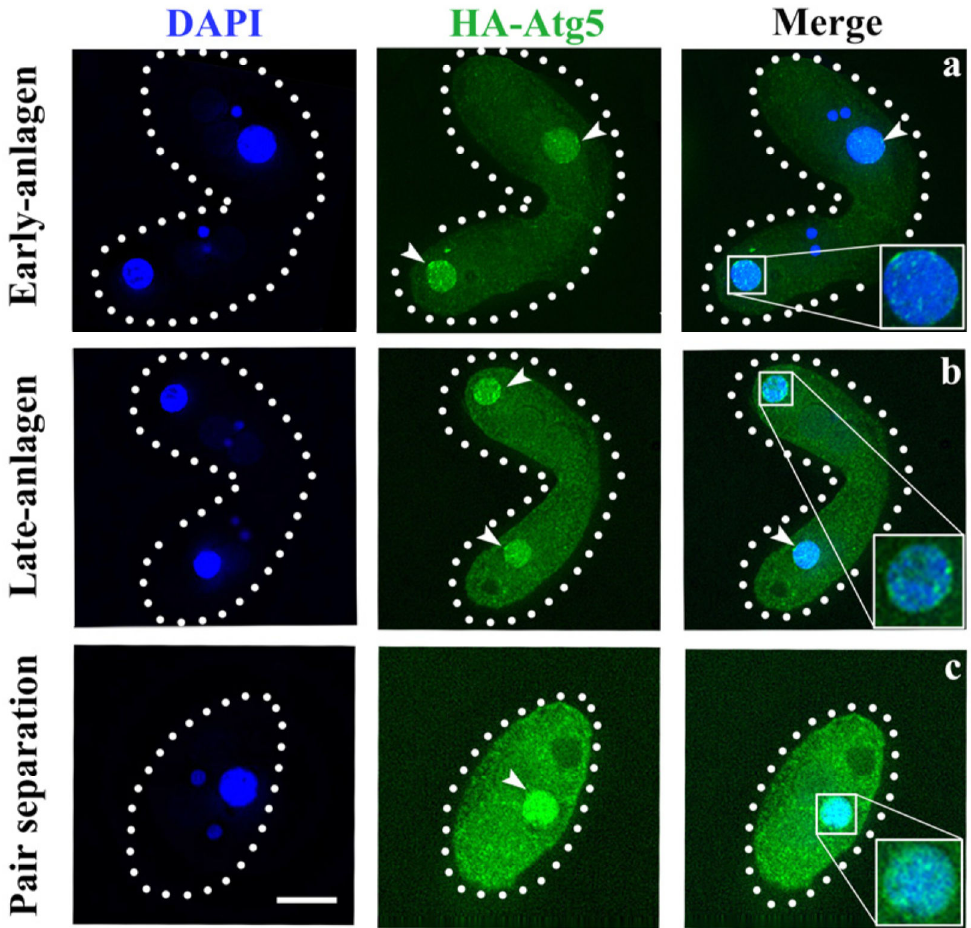
Figure 2. Localization of HA-Atg5 during the sexual reproduction of Tetrahymena thermophila . Cells collected at 6, 8, and 12 h after mixing were fixed and processed for immunofluorescence staining with anti-HA primary and FITC-conjugated secondary antibodies. Cellular nuclei were stained with DAPI to visualize DNA. ( a ) cells at the early-anlagen stage; ( b ) cells at the late-anlagen stage; ( c ) cells at the pair separation stage. Dashed circle represents the cell outline of Tetrahymena . The white arrows point to the paMAC to be degraded. The white box shows a sharp enlargement of the paMAC.Fluorescent images were taken with a DeltaVision deconvolution microscope. Scale bar, 10 µ